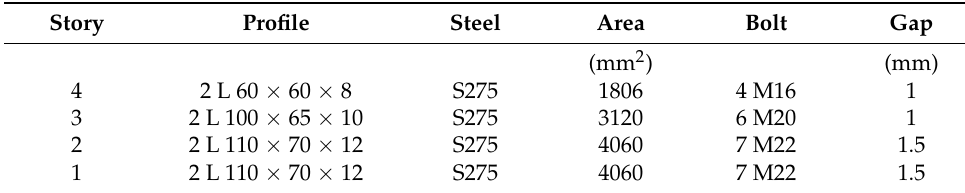
Table 3. Steel bracing